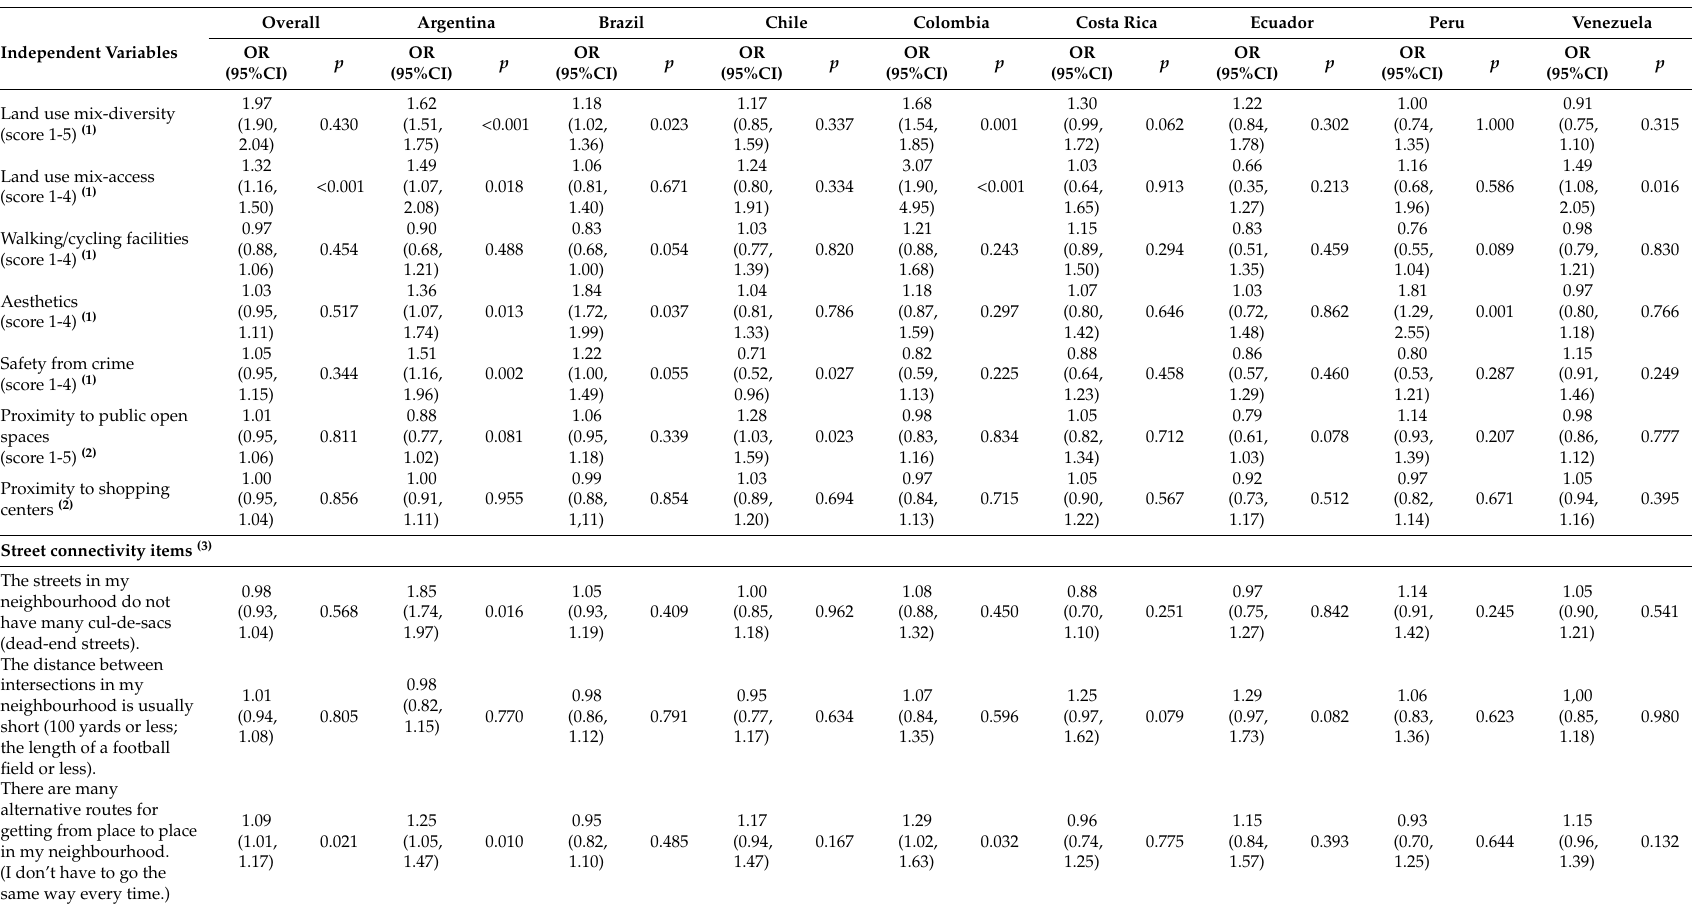
Table 4. Multilevel logistic regression models (OR (95%CI)) for walking for transport (0: < 10 min / week, 1: ≥ 10 min / week) by country.